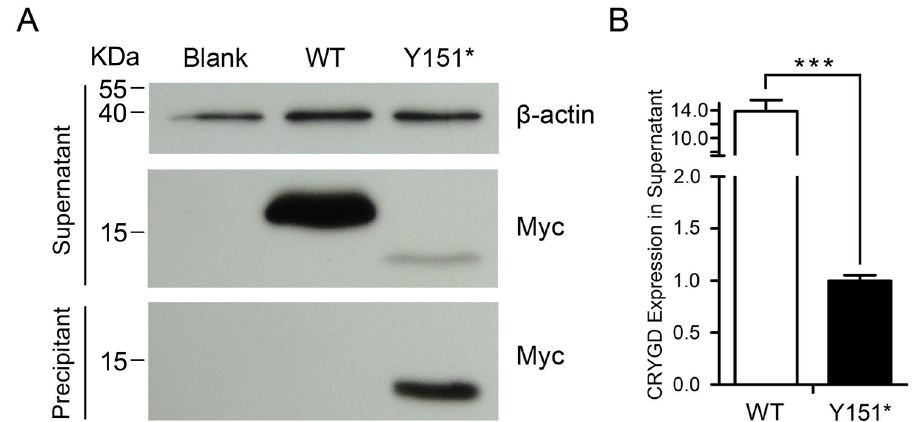
Fig 4. Western blot analysis of CRYGD over-expression in HEK293T cells. (A) The truncated CRYGD showed decreased solubility. In the supernatant, the mutant protein was truncated and was present in much lower amounts than the wildtype. In the precipitant, there was more mutant protein and the wildtype was not detected. (B) Quantification by band densitometry indicated the prominent reduction of mutant CRYGD in the supernatant (p < 0.05).